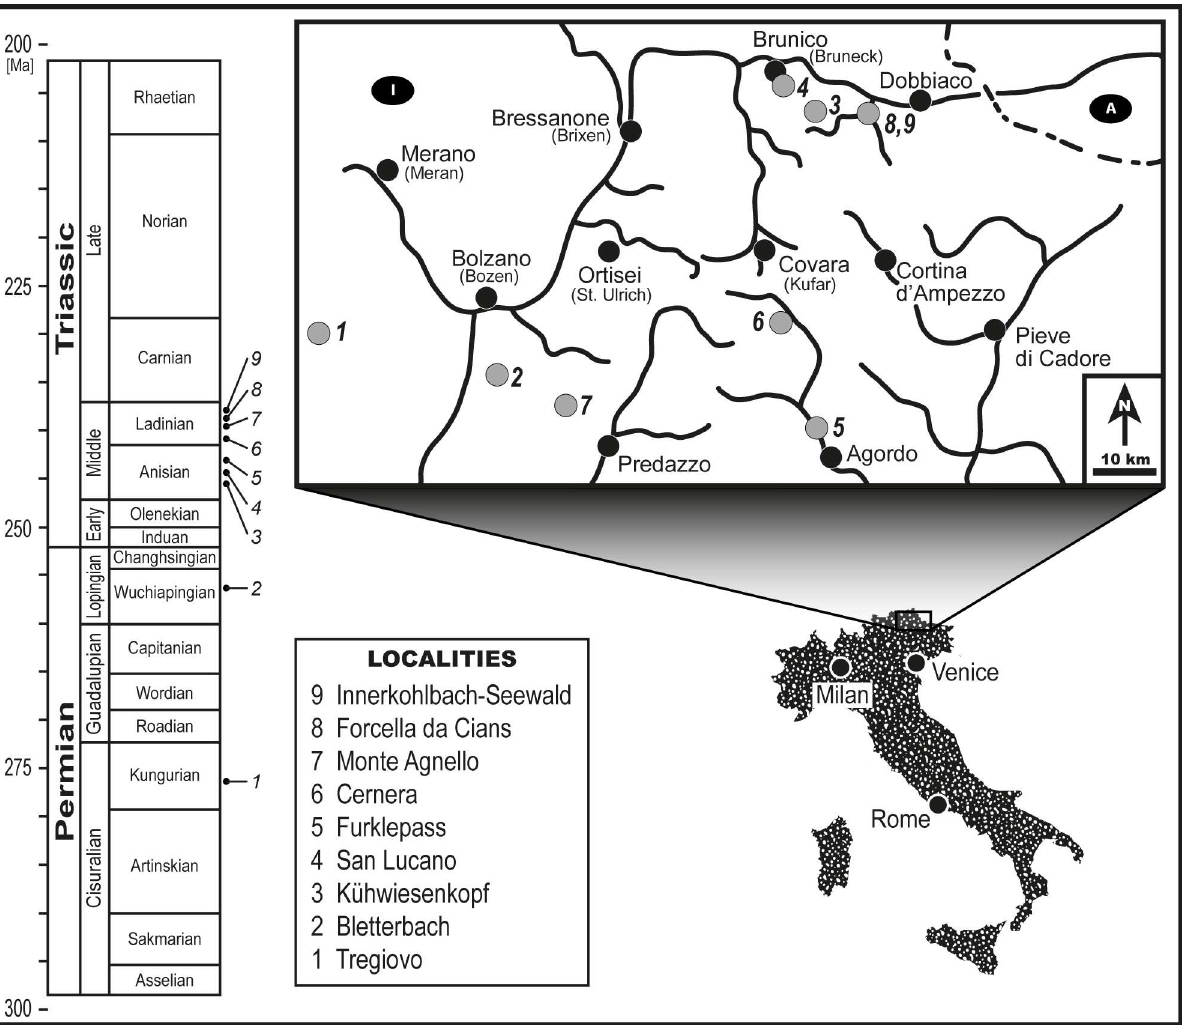
Fig 1. Stratigraphic and geographic context of localities that provide plant–insect interaction data for the Permian–Triassic sequence from the Dolomites Region in northeastern Italy. Geologic scale is after [76]; grey dots designate localities discussed in this report black dots refer to principaltowns and villages;and lines delimit major